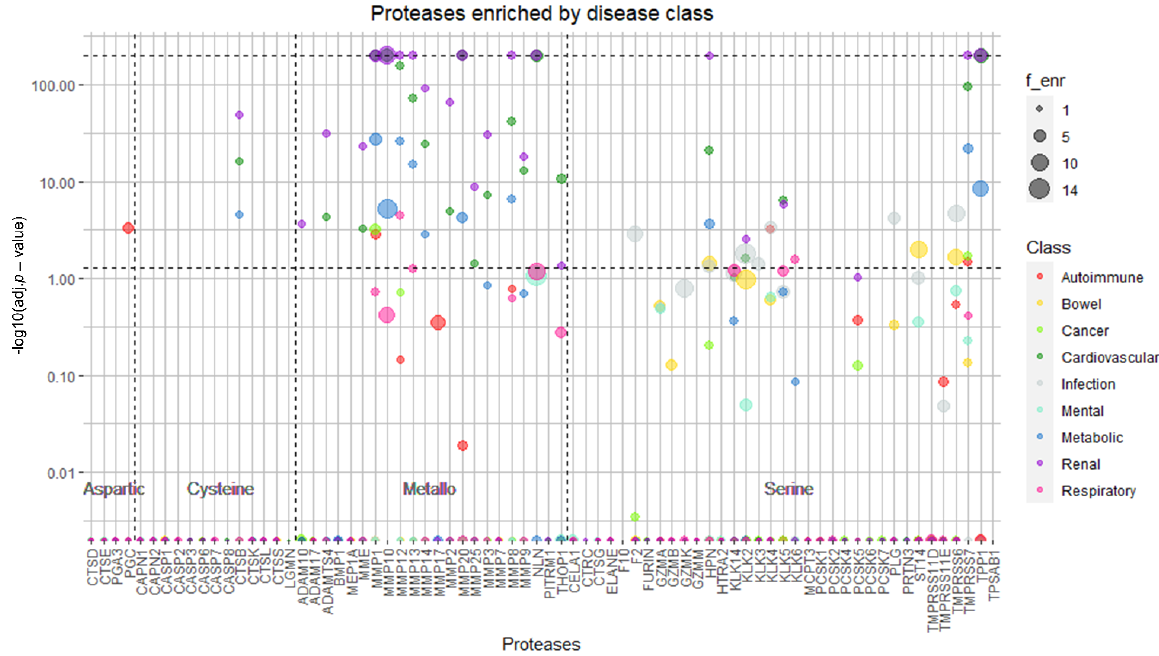
Figure 5. Protease fold-enrichment in the various disease classes: autoimmune (red), bowel (yellow), cancer (light green), cardiovascular (dark green), infection (grey), mental (cyan), metabolic (dark blue), renal (purple), and respiratory (pink) diseases. The size of the circles representing each protease is proportional to the magnitude of the enrichment. Proteases are arranged vertically according to the Bonferroni corrected p -value of the enrichment (hypergeometric test). The central horizonal line marks the significance threshold ( p = 0.05). For representation purposes, proteases showing − log10( p -value) > 200 were set to − log10( p -value) = 200 and are represented on top of the upper horizonal